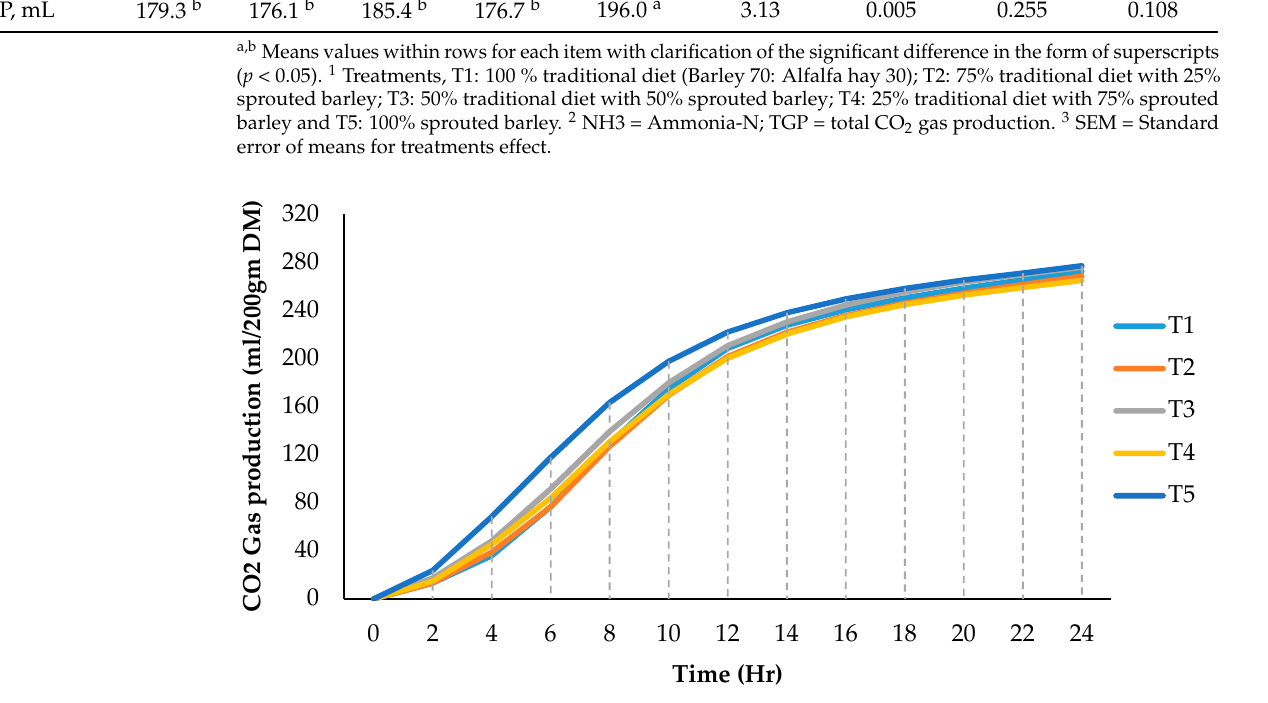
Figure 1. Cumulative CO2 gas production during the in vitro digestion for dietary treatments from 2 to 24 h.